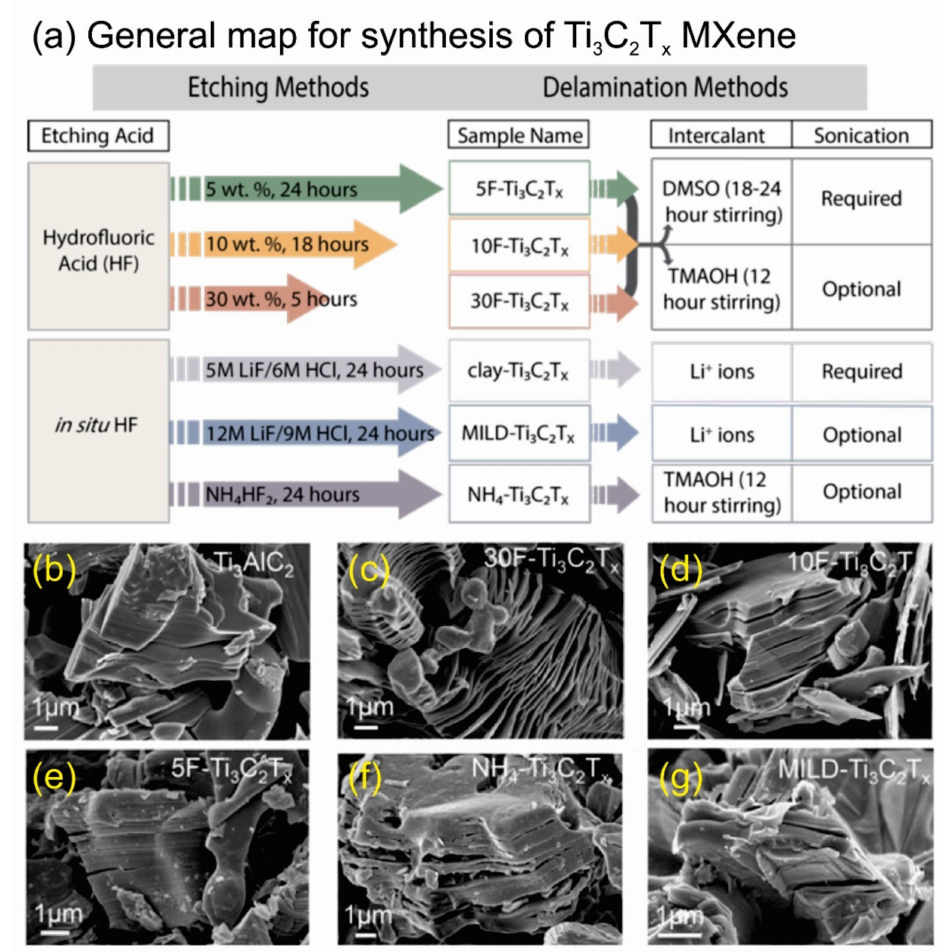
Figure 3. ( a ) The schematic diagram representing the process to prepare Ti 3 C 2 T x by using di ff erent etchants (HF and in situ HF) and delamination methods and ( b – g ) their corresponded